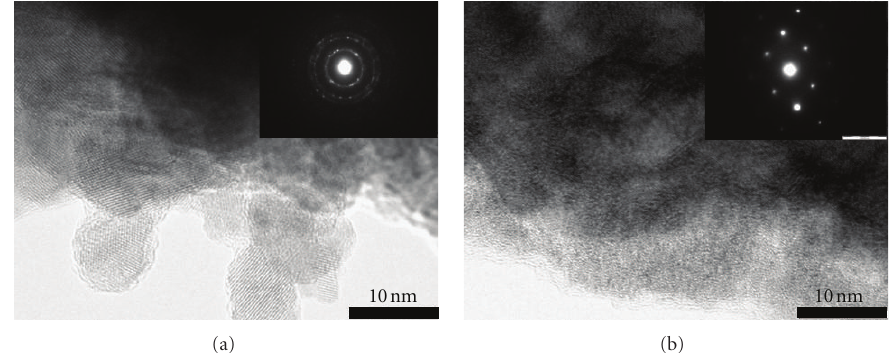
Figure 5: TEM image of spray-pyrolysis-deposited Cu-In-S with the electron di ff usion patterns (inset) on a glass/TiO 2 substrate: (a) the major part and (b) the minor part.